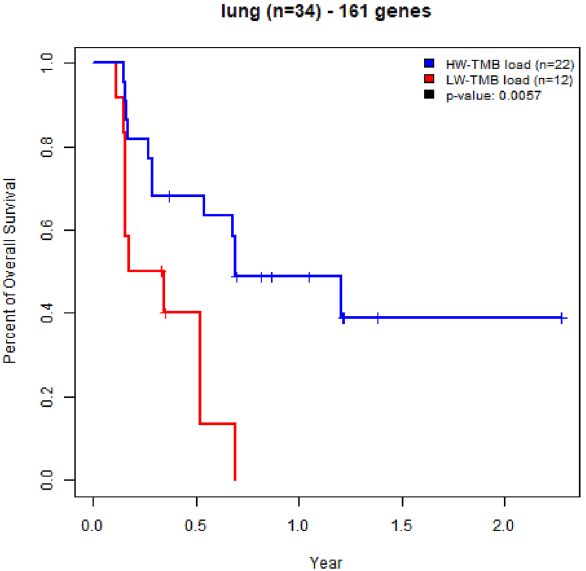
Figure 4. Kaplan–Meier curves for overall survival in advanced non-small cell lung cancer patients treated with immune checkpoint blockade immunotherapy (testing data n = 34); patients with high-weight tumor mutation burden (HW-TMB) had significant longer survival, compared to those with low-weight tumor mutation burden